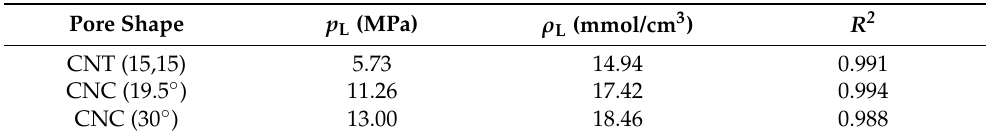
Table 3. Langmuir isotherm parameters of methane obtained using nonlinear fitting for CNT/CNC, T= 338 K.